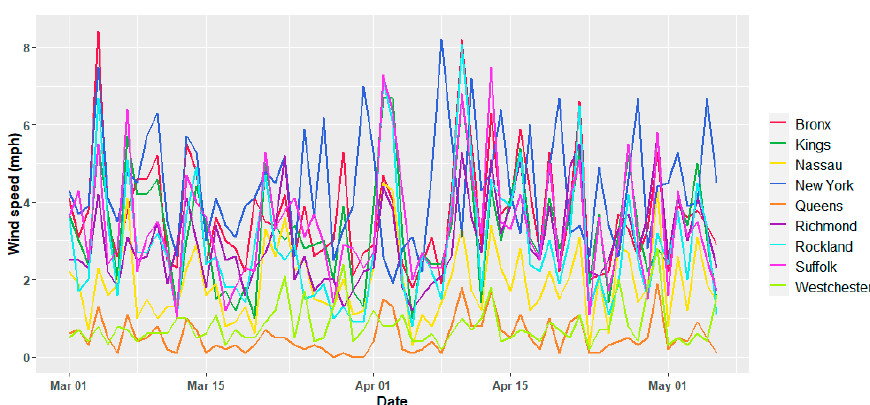
Figure A3. Variation of daily average wind speed for individual counties.